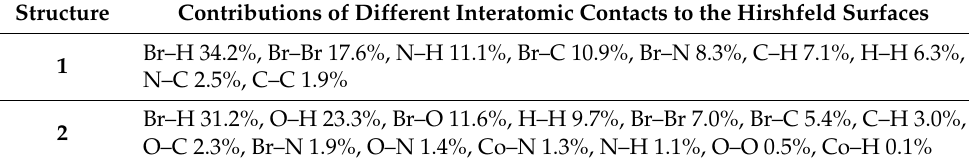
Table 2. Main partial contributions of different interatomic contacts to the Hirshfeld surfaces of X-ray structures 1 and 2 . Structure Contributions of Different Interatomic Contacts to the Hirshfeld